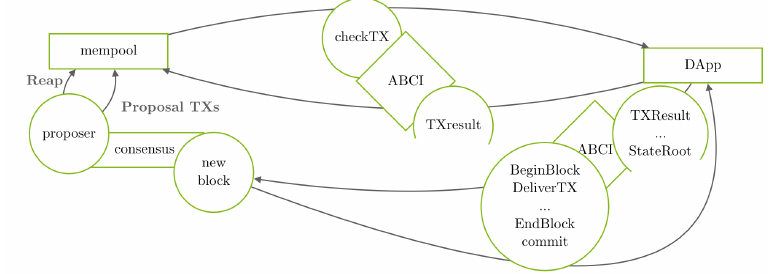
Fig. 4. Tendermint consensus protocol as used in